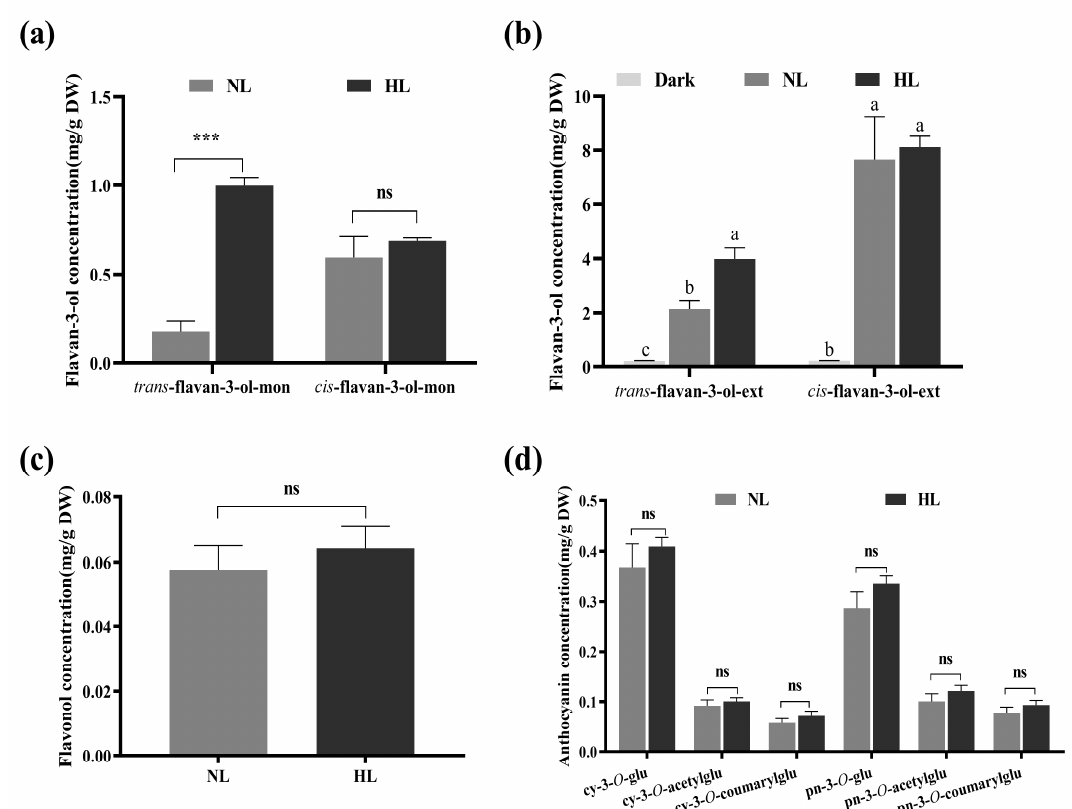
Figure 2. The concentrations of flavonoid components in grapevine calluses under different light intensity treatments. NL and HL mean the grapevine calluses cultured in control condition and high light, respectively. DW: dried weight. ( a ) The concentrations of cis / trans -flavan-3-ol monomers. “mon” mean monomers, including free monomers and starter units; ( b ) the concentrations of cis / trans -flavan-3-ols served as extension units in proanthocyanidin (PA) polymerization. “ext” mean extension units. Lower case letters indicate the significant differences among the treatments by one- way ANOVA test ( p < 0.05); ( c ) the concentration of flavonols; ( d ) the concentration of anthocyanins. cy-3- O -glu: cyanidin-3- O -glucoside; cy-3- O -acetylglu: cyanidin-3- O -acetyl-glucoside; cy-3- O - coumarylglu: cyanidin-3- O - p -coumaryl-glucoside; pn-3- O -glu: peonidin-3- O -glucoside; pn-3- O- acetylglu: peonidin-3- O -acetyl-glucoside; pn-3- O -coumarylglu: peonidin-3- O - p -coumaryl-glucoside. Each sample was individually assayed in triplicate. Error bars indicate the standard error of the mean. The “ns” or asterisk* in ( a , c , d ) indicate significant differences between the treatments by one-way ANOVA test (ns, not significant; ***, p < 0.001).